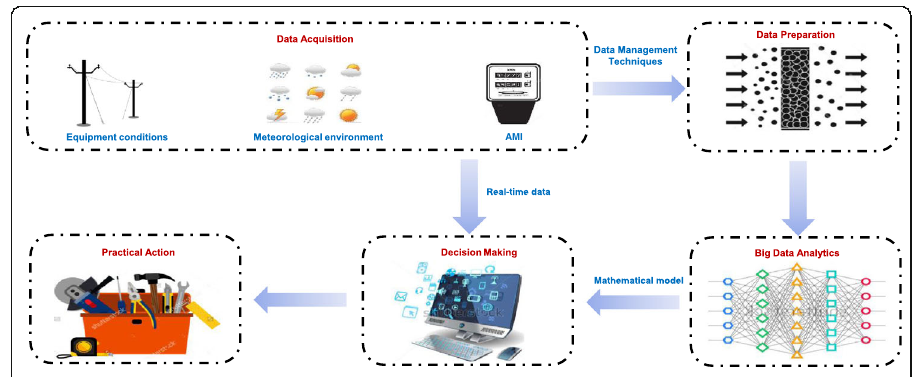
Fig. 4 Example of big data analytic procedures in smart